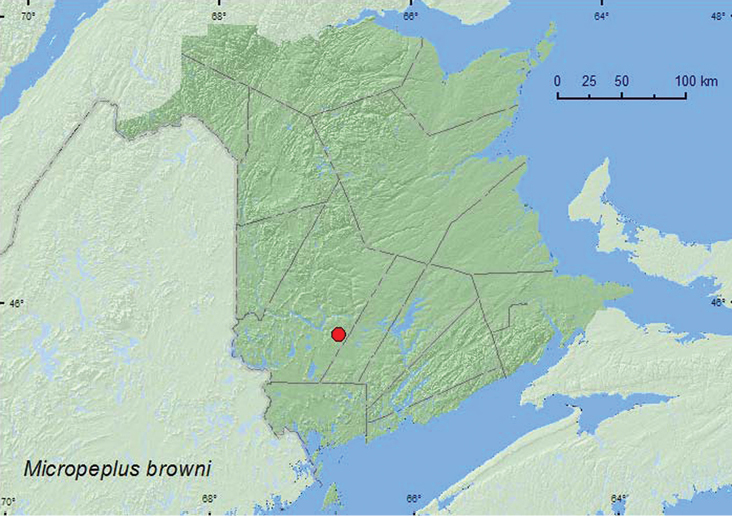
Collection localities in New Brunswick, Canada of Micropeplus browni